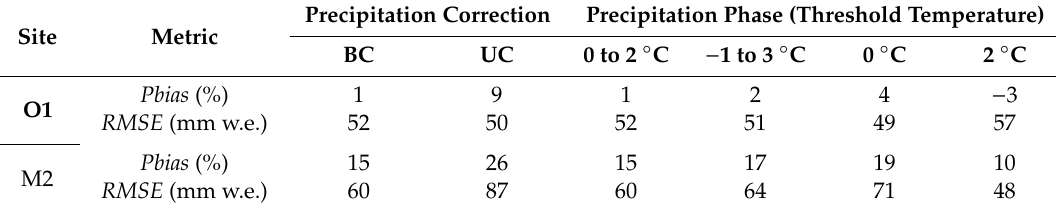
Table 3. Metrics for the best-performing TI model from Phase II (with sublimation) considering precipitation undercatch and precipitation phase comparison. uncorrected